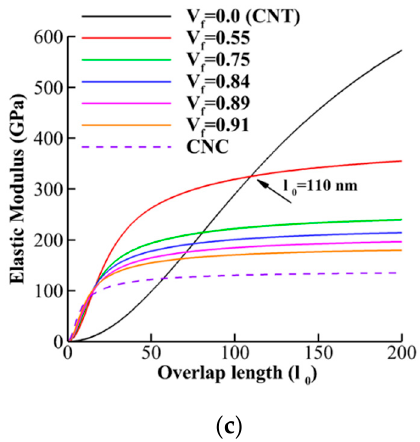
Figure 11. ( a ) Staggered arrangement of CNT-wrapped cellulose fibers with 50% overlap length. ( b ) Strength of nanopaper for different overlap length and cellulose content ( c ).